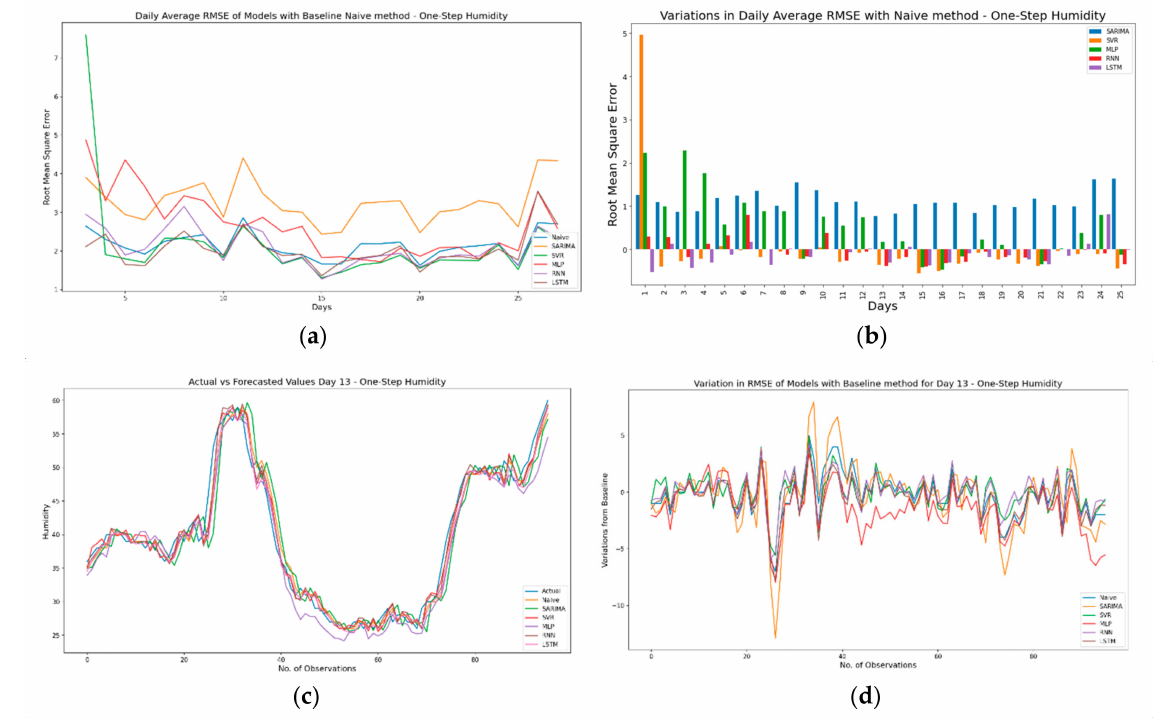
Figure 14. Comparative visualization for model performance against a baseline model—One-step ahead Humidity ( a ) daily average RMSE of different models with the baseline naïve model ( b ) variations in daily average RMSE with performance against naïve model ( c ) combined Actual vs. Forecasts generated by different TSFAs for Day 13 ( d ) variations in RMSE of models against the naïve model for Day 13.